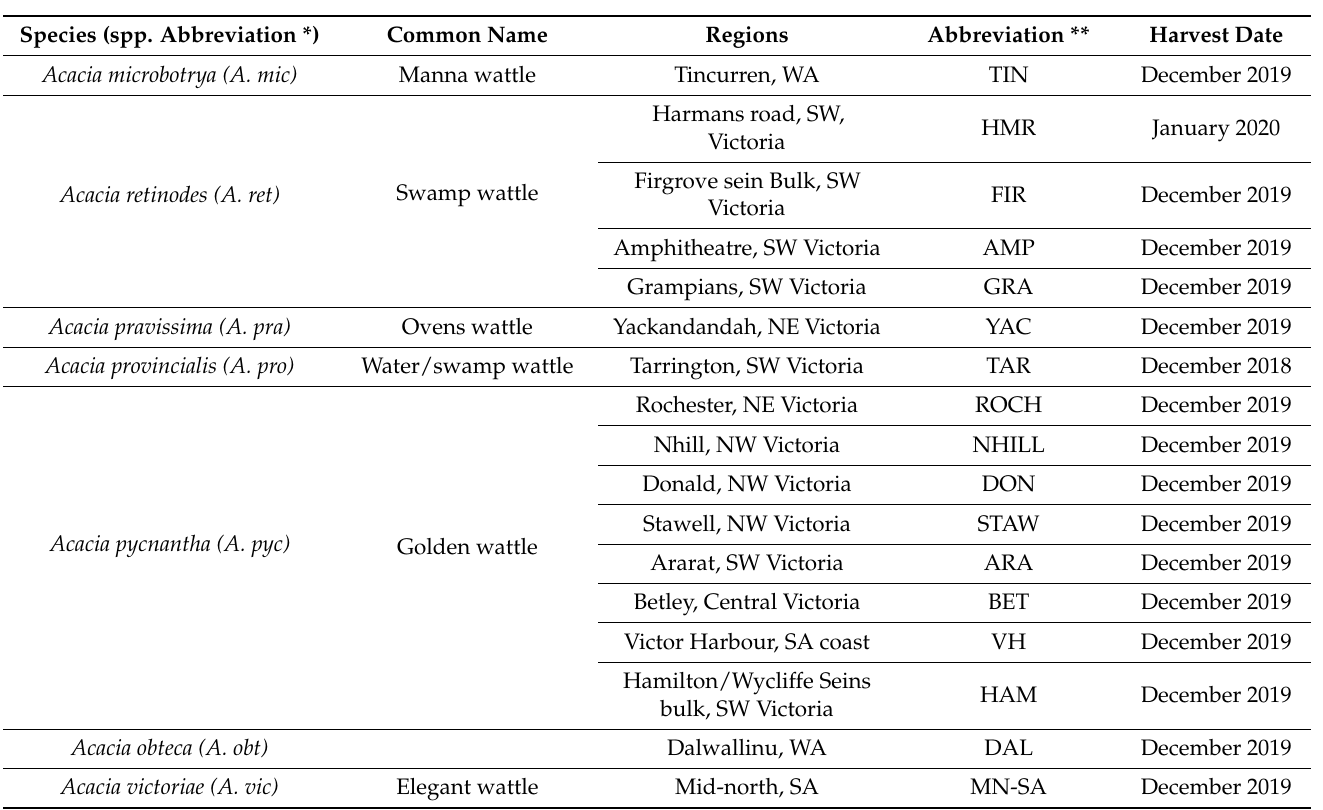
* abbreviations for species, ** abbreviations for